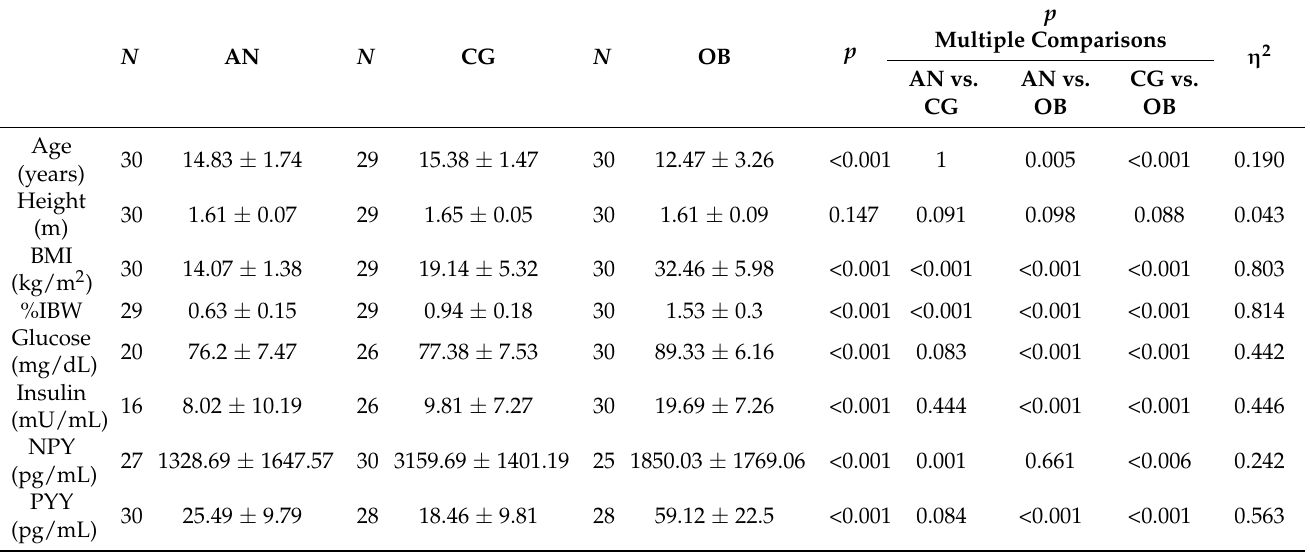
Table 1. Age, height, body mass index (BMI), percentage of ideal body mass (% IBW), and fasting serum levels of glucose, insulin, neuropeptide Y (NPY), and peptide YY (PYY) in adolescents with anorexia nervosa (AN) or obesity (OB), as well as in the healthy control group